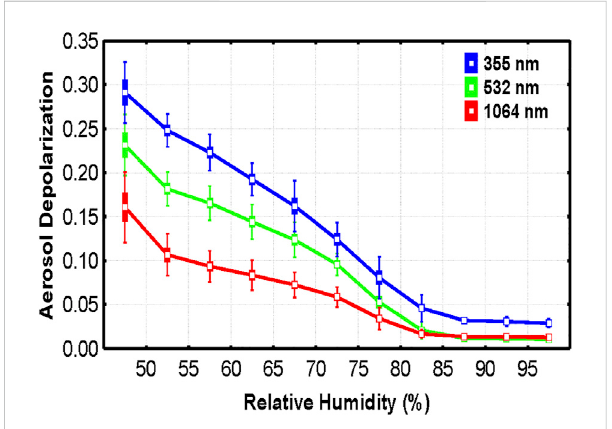
FIGURE 6 Box plot showing aerosol depolarization measured by HSRL-2 as afunctionofRHaveragedoverthefourdropsondetimesforthe fl ights on 8 March 2020. Open squares show mean values, fi lled boxes show mean ± two standard errors, and whiskers show mean ± one standard deviation.